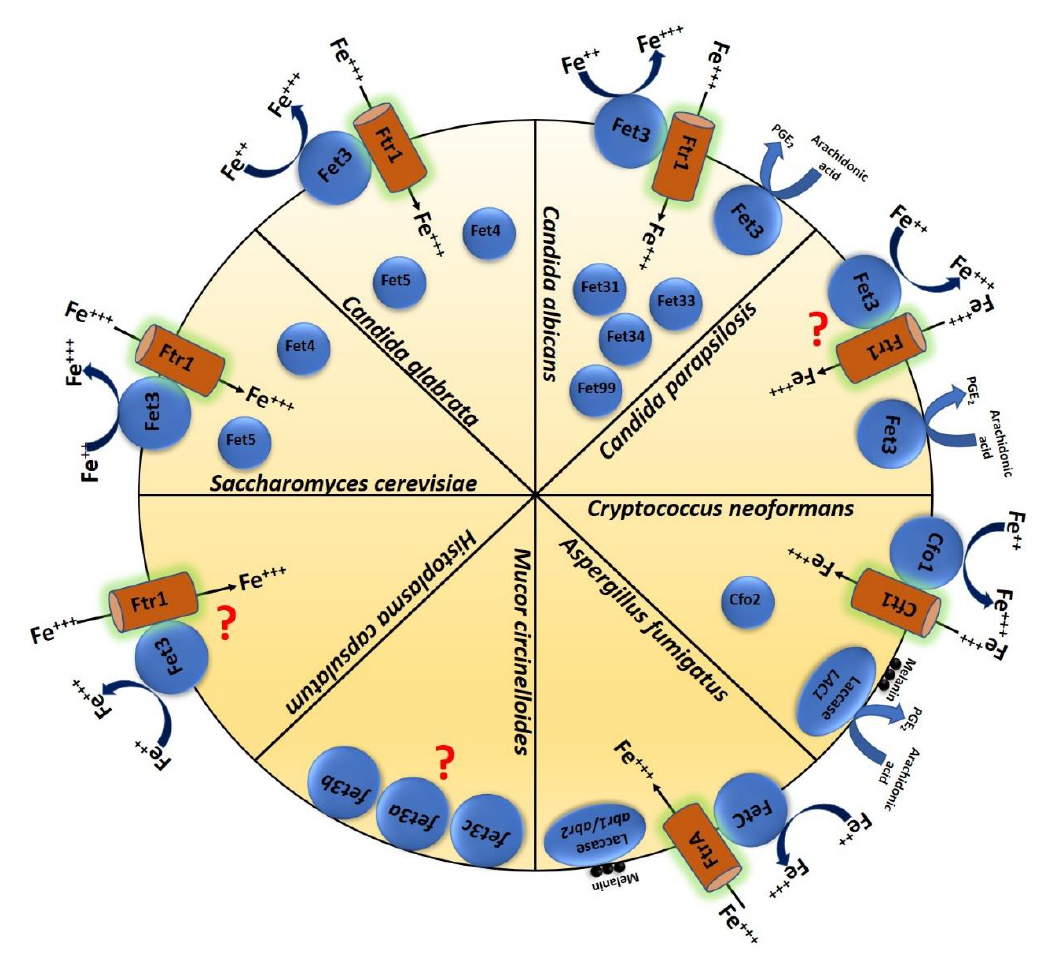
Figure 1. Schematic image showing important multicopper oxidases in different fungal species such as S. cerevisiae , C. albicans , C. glabrata , C. parapsilosis , A. fumigatus , C. neoformans , M. circinelloides, and H. capsulatum and their function.